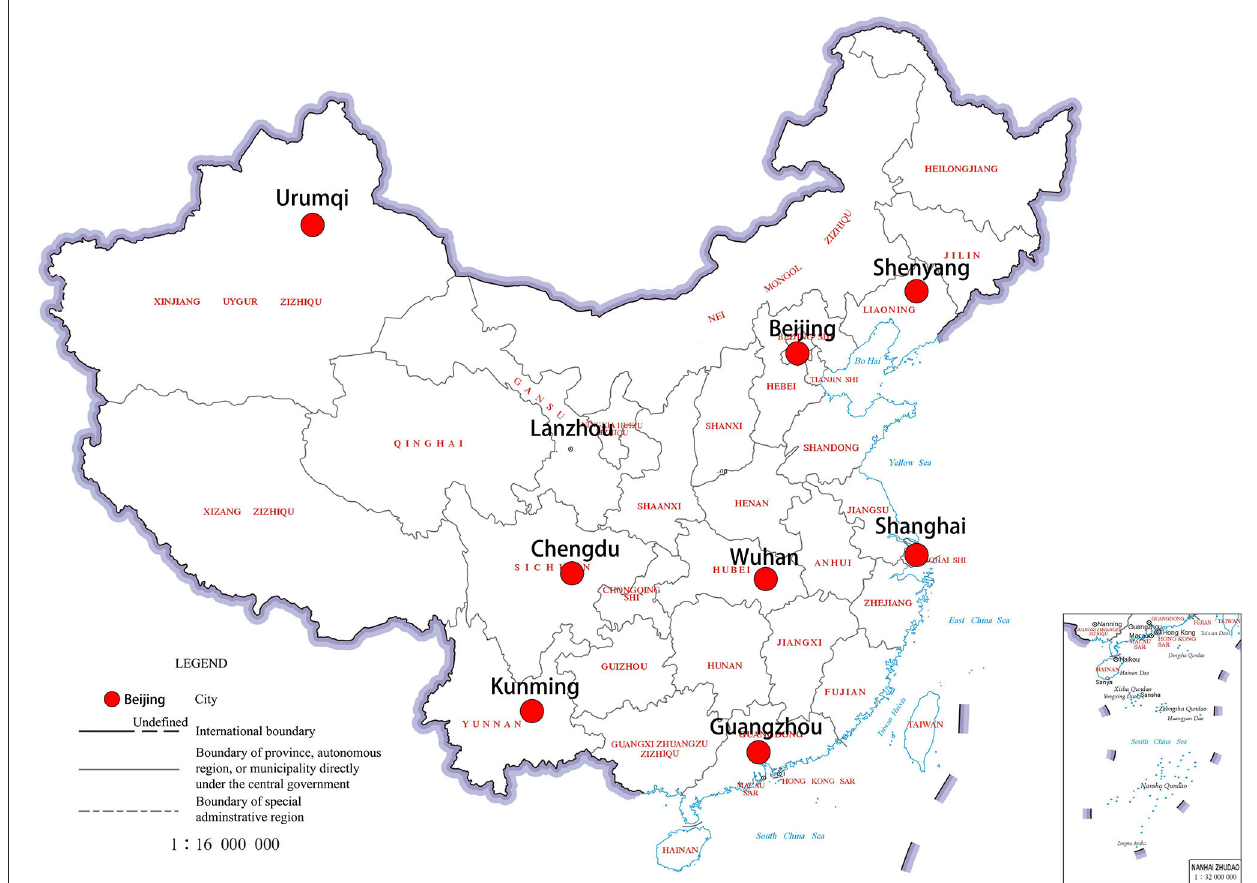
FIGURE 1 | The geographic location of the study